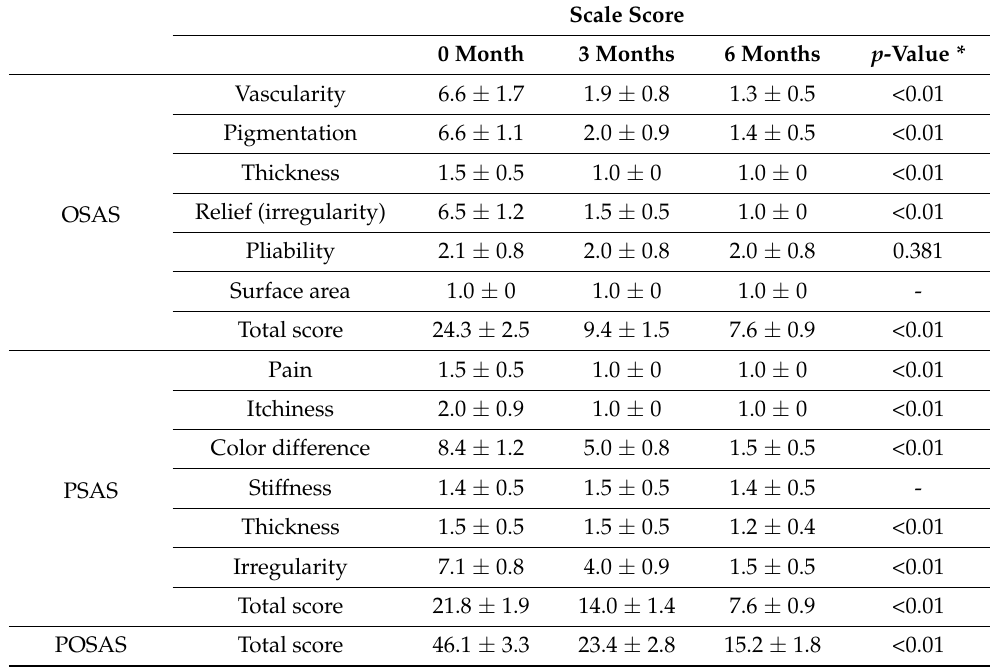
Table 3. POSAS score change after